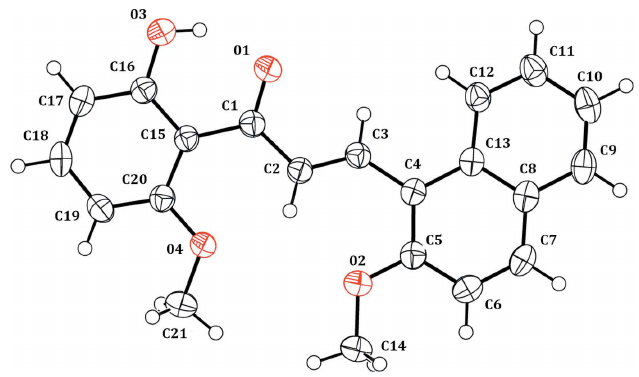
Figure 1 The molecular structure of the title compound with displacement ellipsoids drawn at the 30% probability